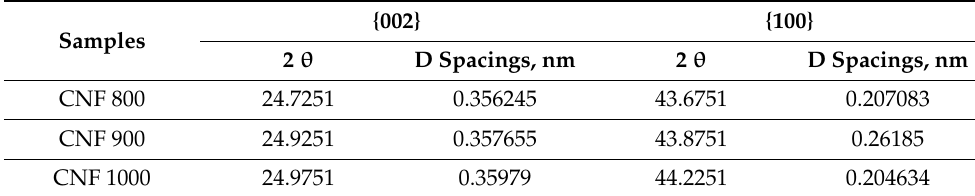
Figure 3. Raman spectra of carbon fibers: ( a )—800 °C; ( b )—900 °C; ( c )—1000 °C. Table 1. Interlayer spacing parameters of the